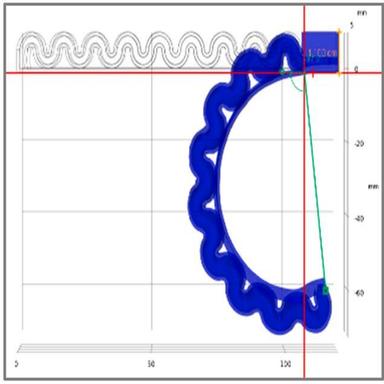
Displacement analysis (20 psi).